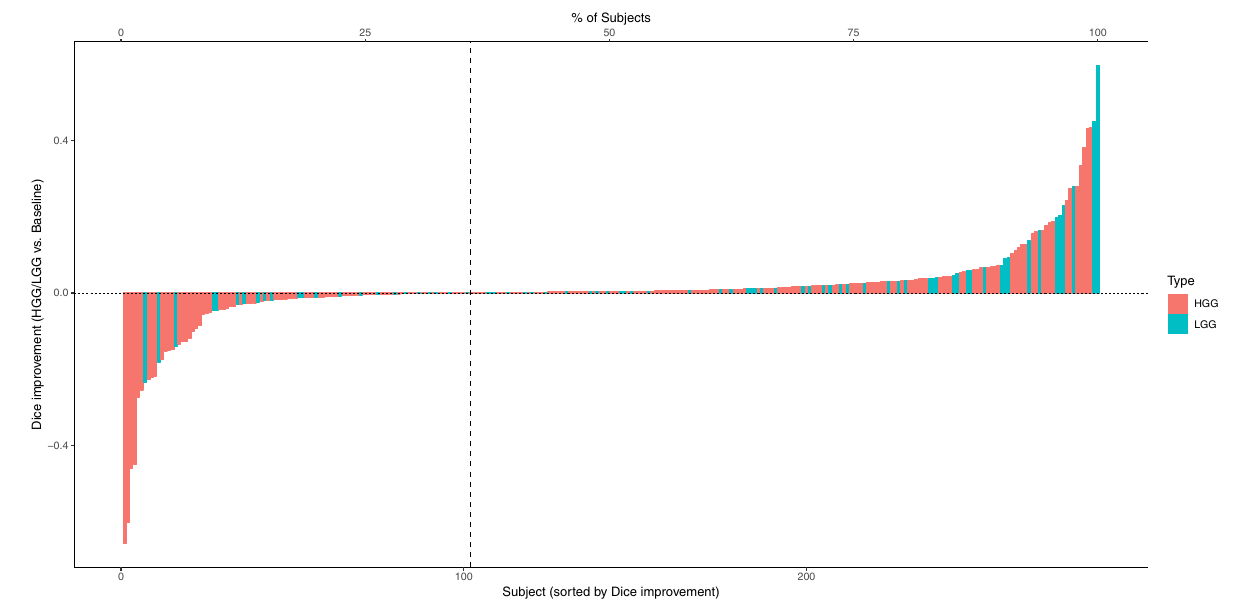
FIGURE 2 | Absolute change of Dice coefficients of the tumor core for each subject. Positive changes were observed for the subjects on the right side of the dashed vertical line.